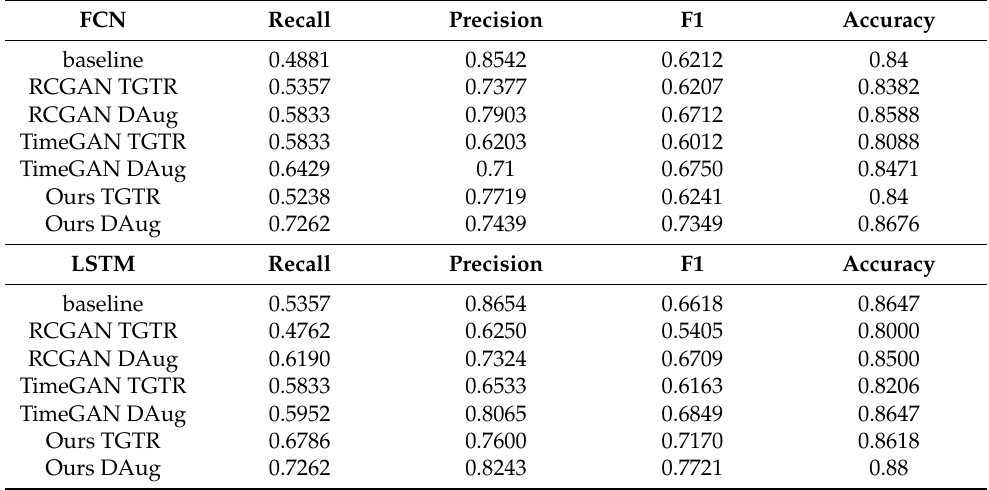
Table 1. The results from the classifier experiments are shown. The different scores indicate the best possible results we reached during training.